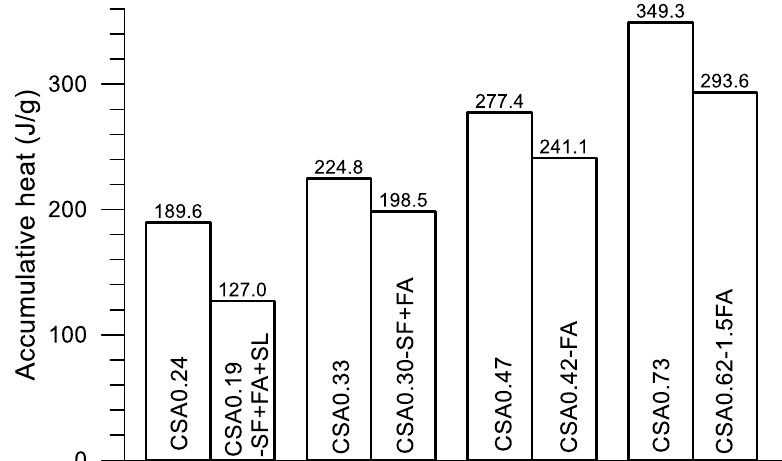
Figure 14. Hydration heat at 160 h of the four pairs of CSA pastes.